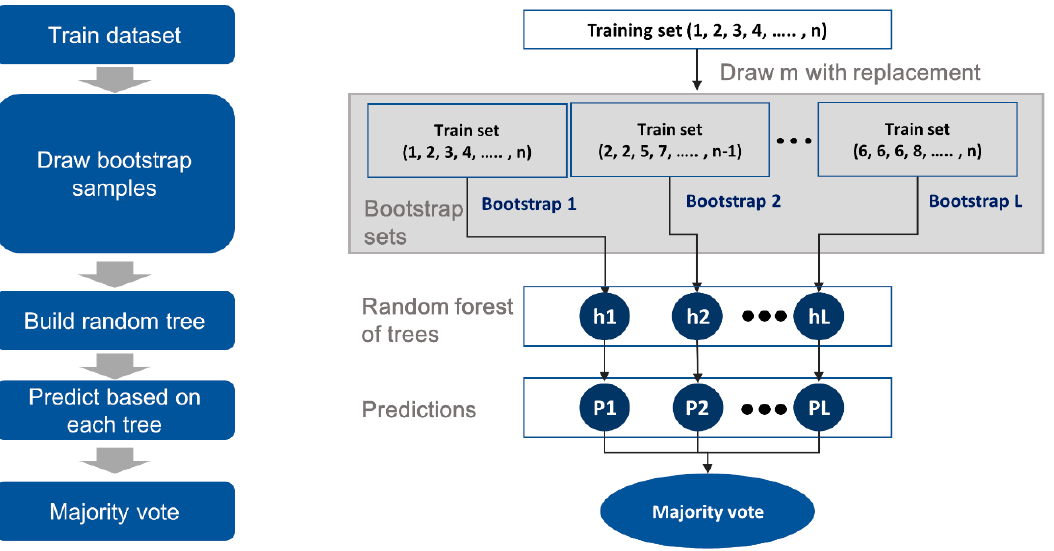
Figure 1. Structure of the random forest (RF) algorithm.